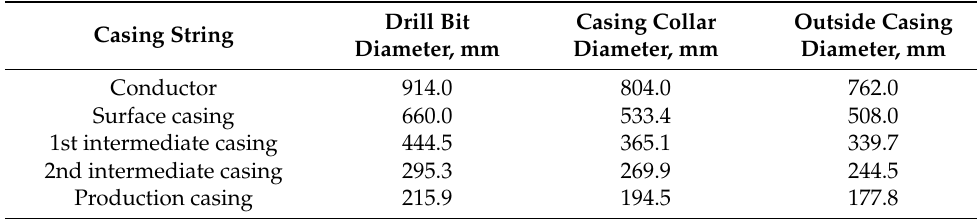
Table 1. Casing design of the exploration well (field